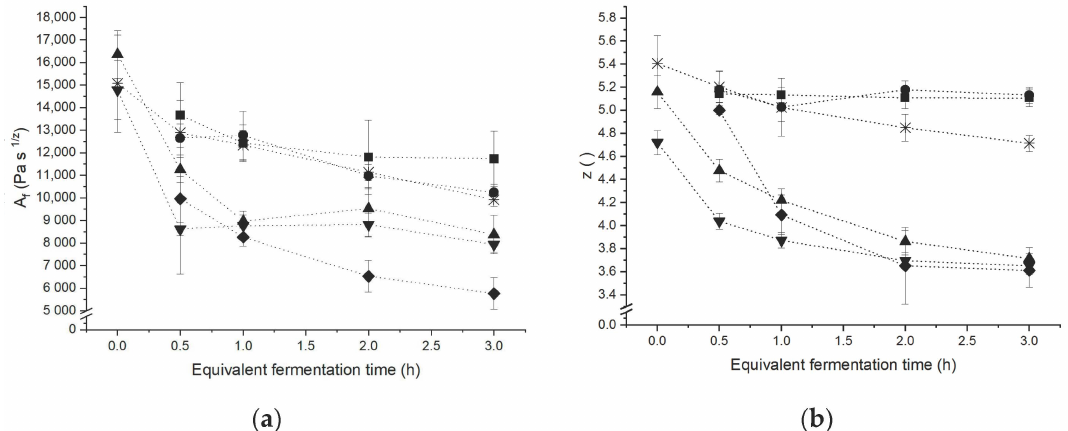
Figure 1. Effect of different yeast levels and yeast metabolites on power law constants during 3 h fermentation at 30 °C. ( a ) Network strength A f . ( b ) Network connectivity z. ( (cid:3) ) Reference without additives, ( ▲ ) 1 g yeast/100 g flour, ( ▼ ) 2 g yeast/100 g flour, ( ♦ ) CO 2 , ( ■ ) succinic acid, and ( ● ) ethanol. The term equivalent fermentation time does not represent a real time for metabolite spiked doughs as those doughs contain the same amount of metabolites as [16] quantified in fermenting doughs (2 g yeast/100 g flour) at the marked time points, but rested for only 0.5 h after kneading. (n = 3, X ± STD).